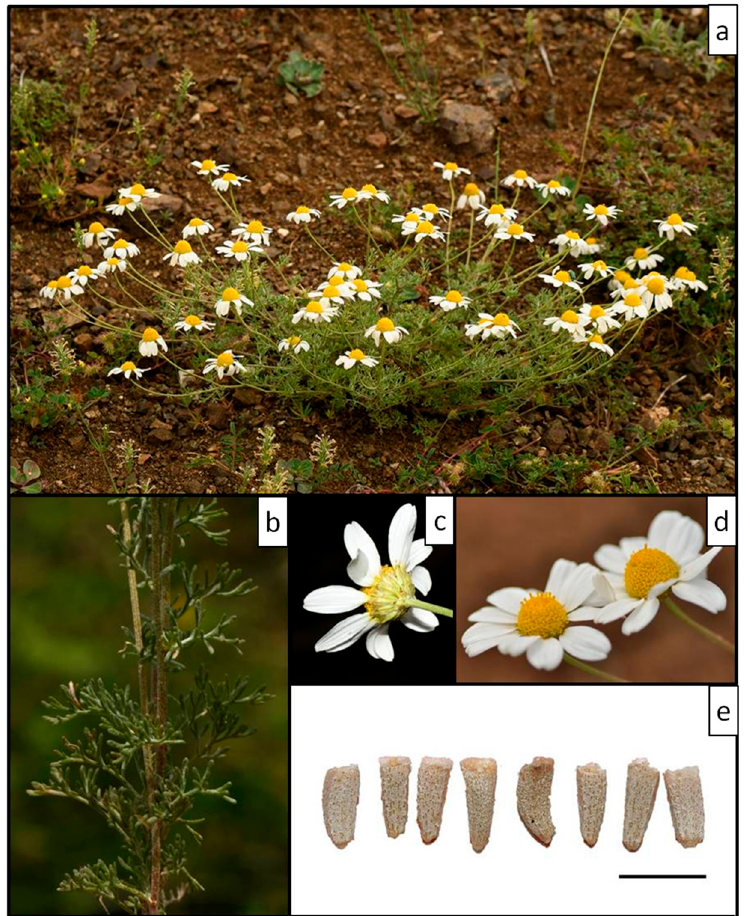
Figure 12. Anthemis serpentinica habit ( a ), leaves ( b ), involucre ( c ), capitula ( d ) and achenes ( e ). Scale bar = 2 mm.